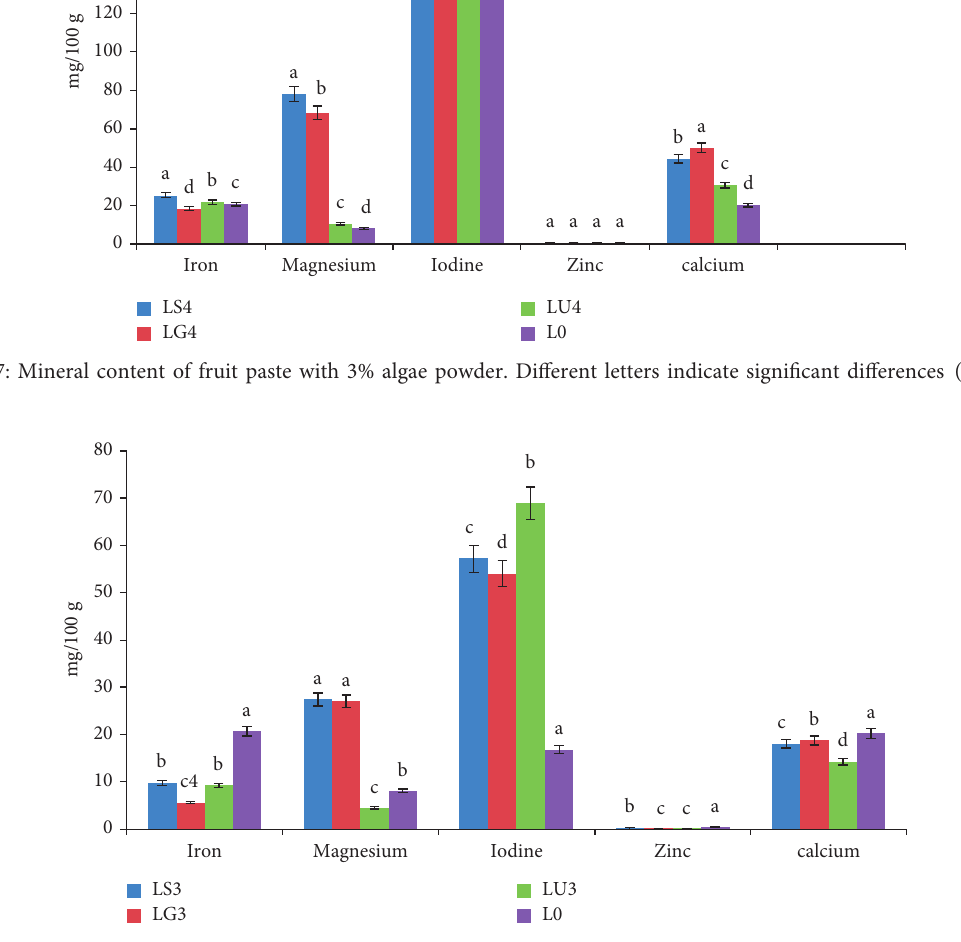
Figure 8: Mineral content of fruit paste with 1.5% algae powder. Different letters indicate significant differences ( p < 0 . 05 )